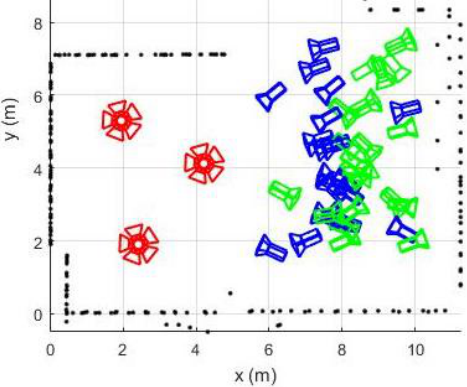
Figure 5. Plan view of the calibration space and camera network configurations in the 3 experiments. Red cameras are the 6 Ladybug5 cameras, green is the GoPro Hero5, blue is the Canon Rebel T3i, the black dots are the targets 1 .